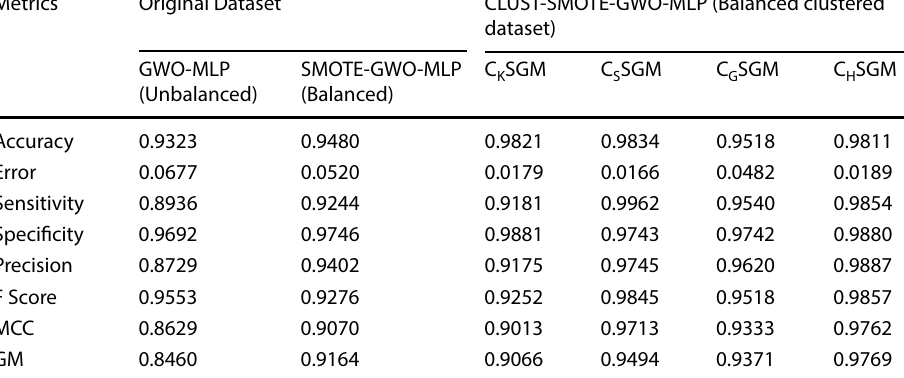
Table 12 Classification performance of